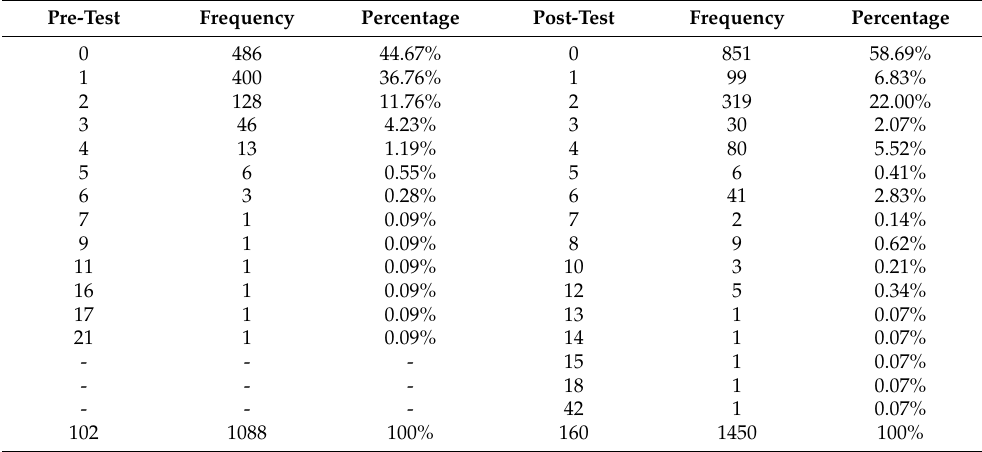
Table 4. Pages visited per session.